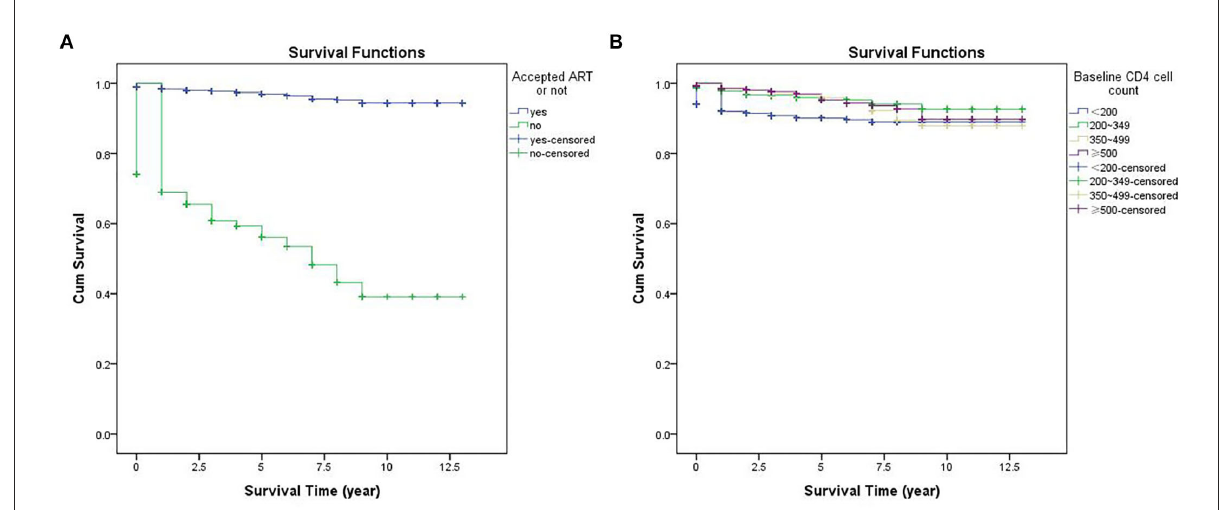
FIGURE2 Kaplan Meier survival curves for PLHIV according to different variables: (A) accepted ART or not; (B) baseline CD4 cell count.